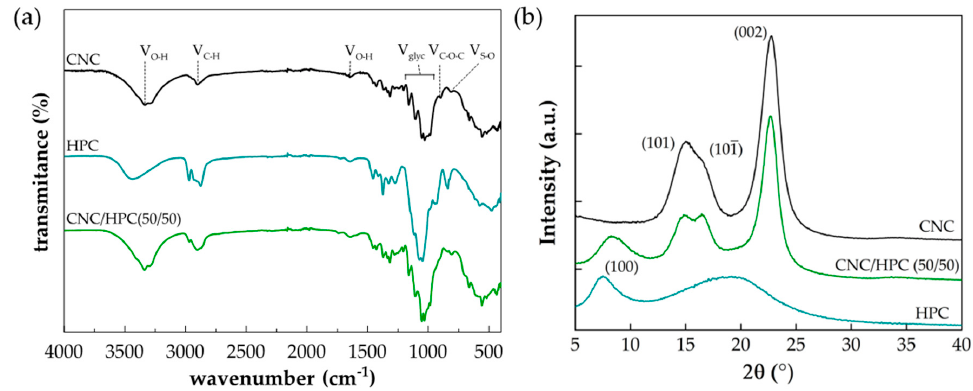
Figure 2. ( a ) FTIR spectra of CNCs, HPC and CNC/HPC (50/50) films; ( b ) XRD patterns of neat CNCs, HPC and CNC/HPC (50/50) composite films.